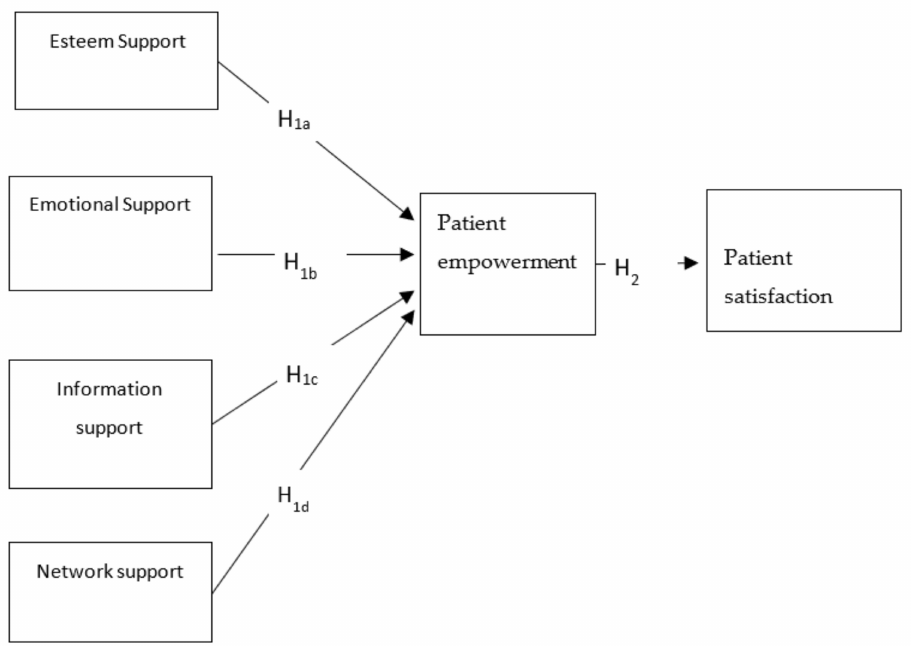
Figure 1. Research